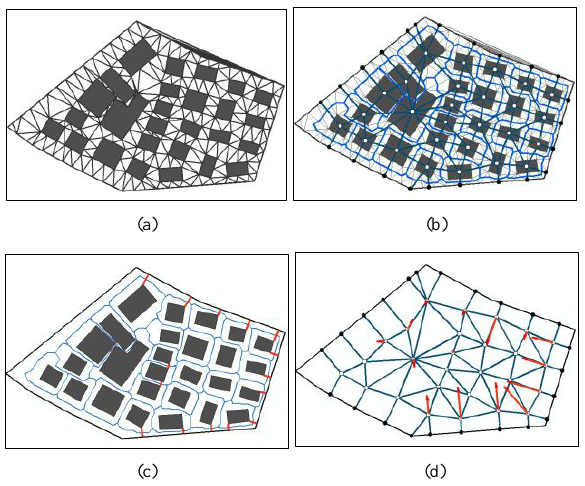
Figure 5. Process of proximity graph construction, conflict detection and forces calculation: (a) Constructing CDT, (b) Extracting skeleton and constructing proximity graph , (c) Detecting conflicts, and (d) Calculating forces (enlarged 5